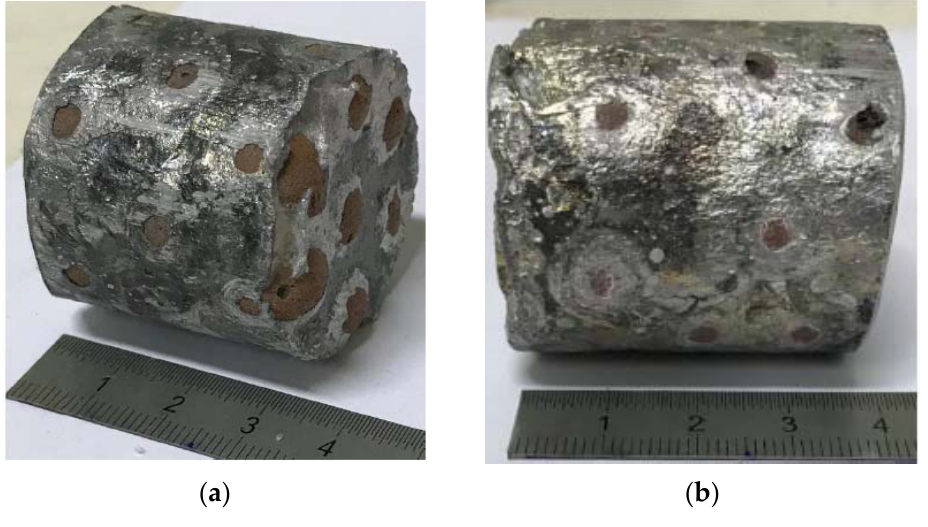
Figure 3. Sample of as-cast Al-ECn, ( a ) base and ( b ) profile.